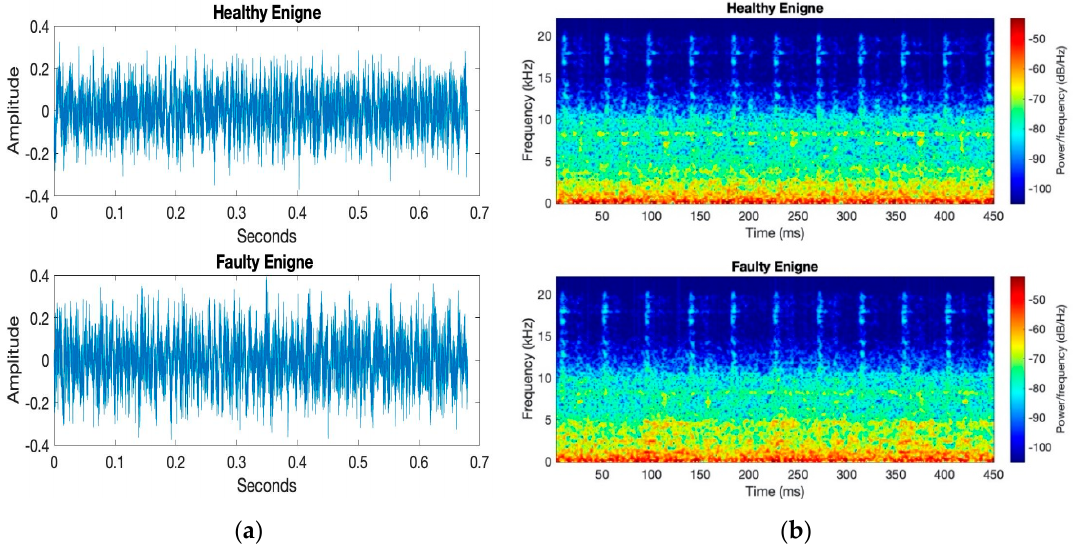
Figure 2. Engine misfire—healthy and faulty: ( a ) signals; and ( b ) spectrogram.